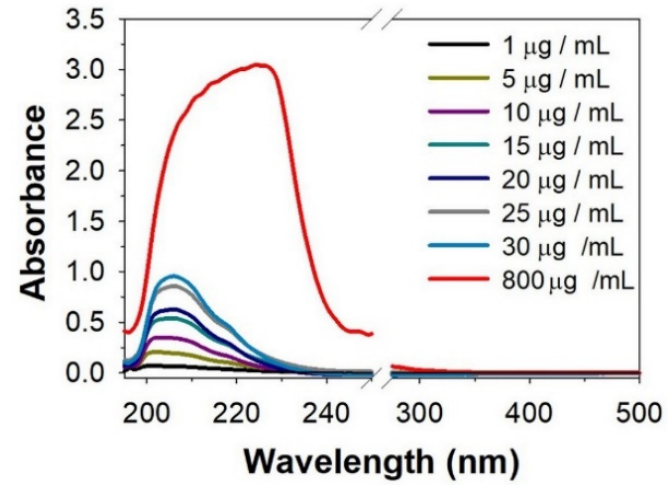
Figure 5. UV–VIS spectra of different standard concentrations solutions of scopolamine.